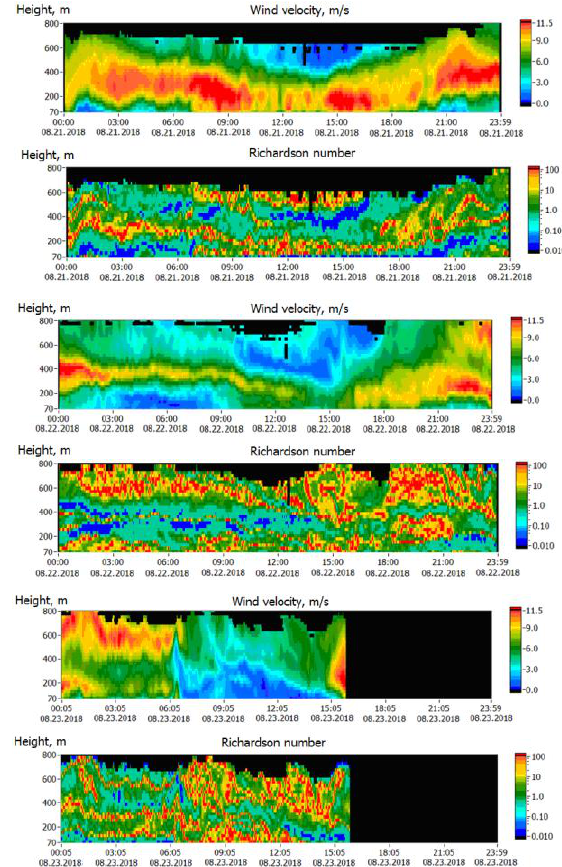
Figure 1 – Spatiotemporal distributions of the wind velocity and the Richardson number for August 21-23 of